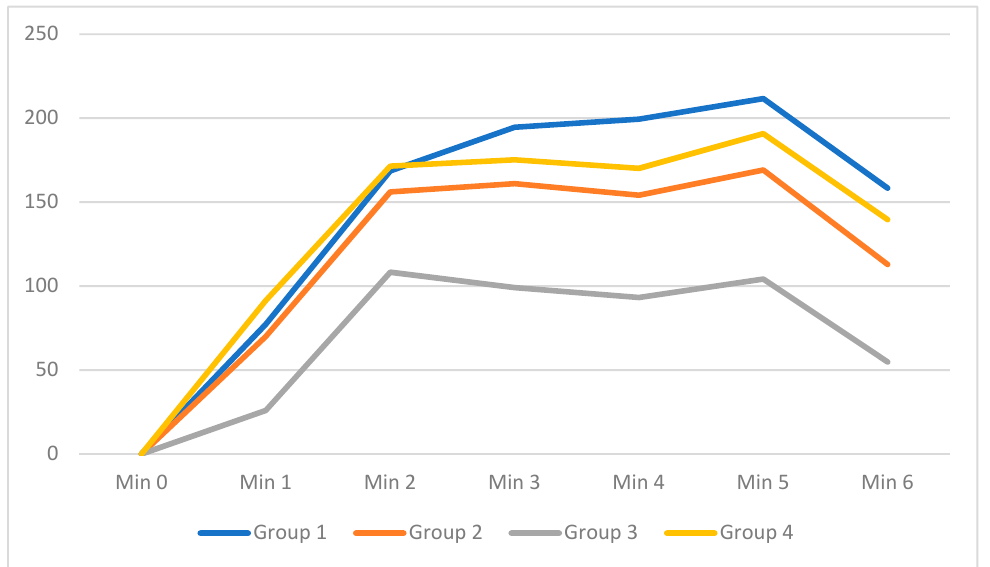
Figure 5. Linear graph of GPx activity (nmol/min/mL) over time from the first to the sixth minute.